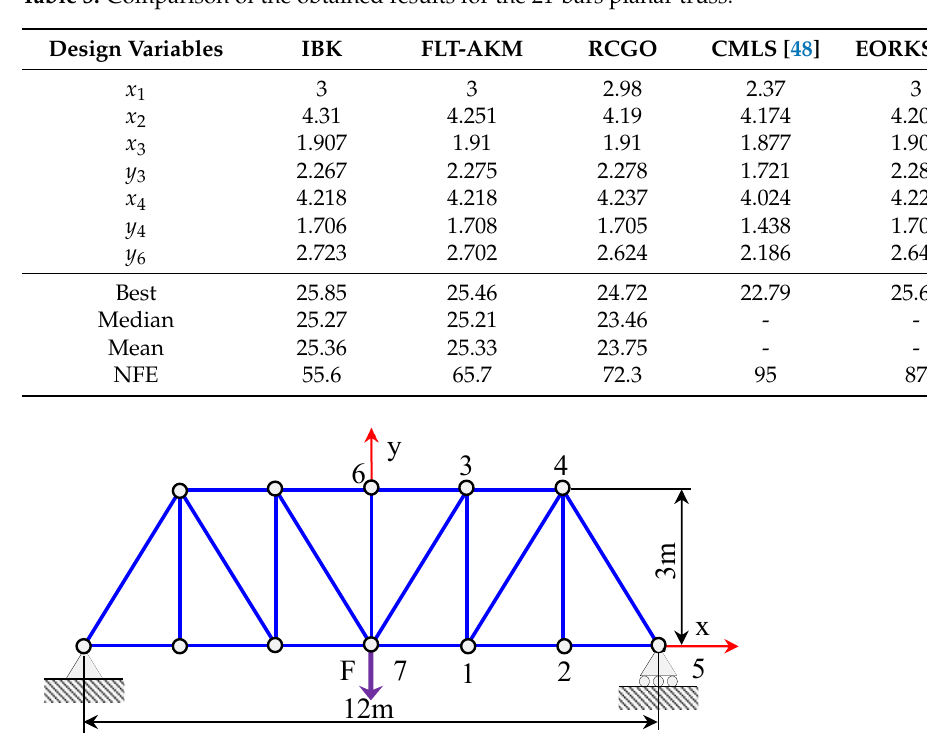
Figure 5. A 21-bars planar truss